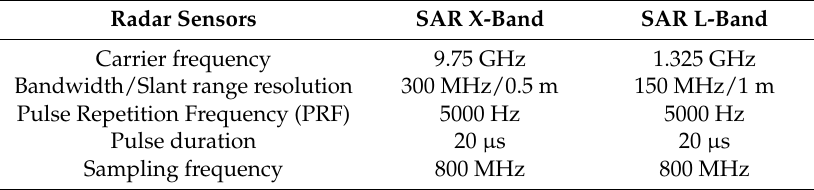
Table 3. Radar waveform operated during the NOFO oil-on-water exercise.